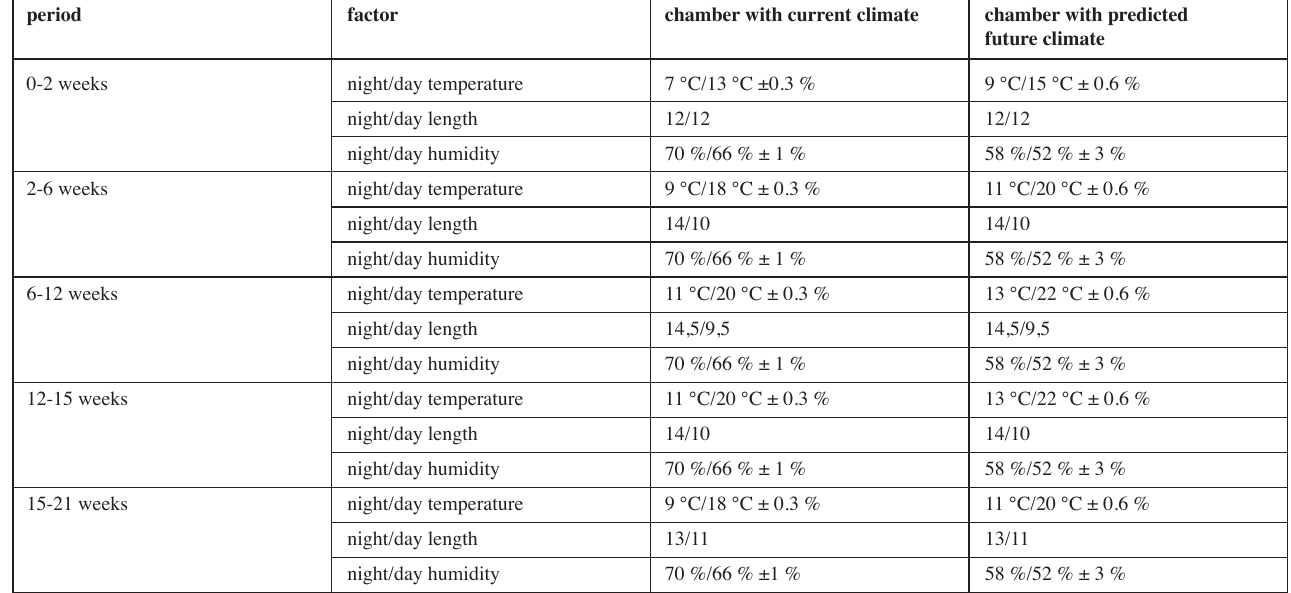
Tab. 1: Conditions in the two climate chambers. Values given after ± are the mean variations between replications. period factor